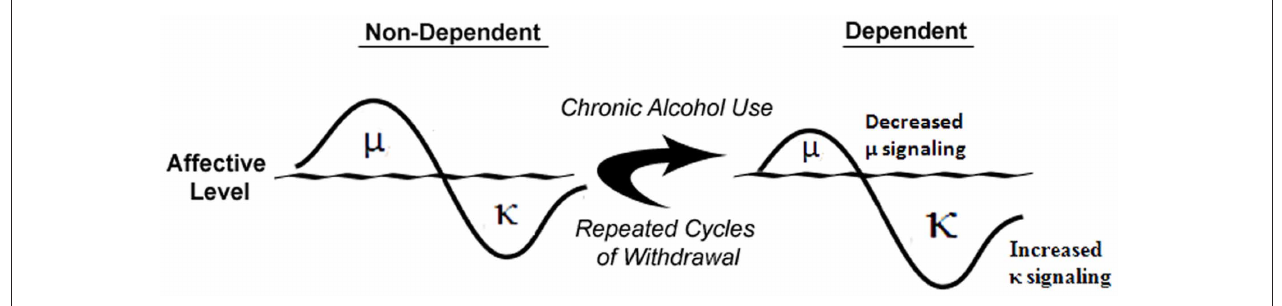
FIGURE 2 | Alcohol dependence-induced change in opioidergic system. In non-dependentorganisms, alcohol-induced positive affective states mediated by the μ -opioid receptor precede compensatory negative affective states expressed through the κ -opioid receptor. Following chronic